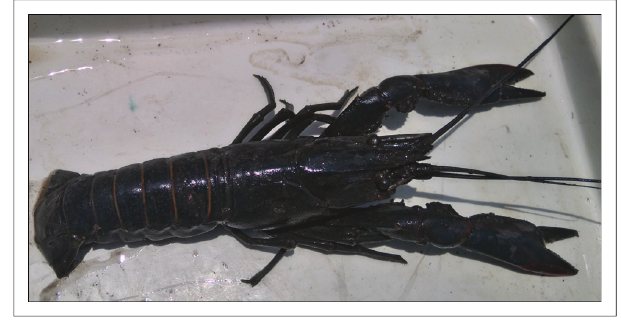
FIGURE 2: Dorsal view of a male redclaw crayfish found in the Crocodile River, South